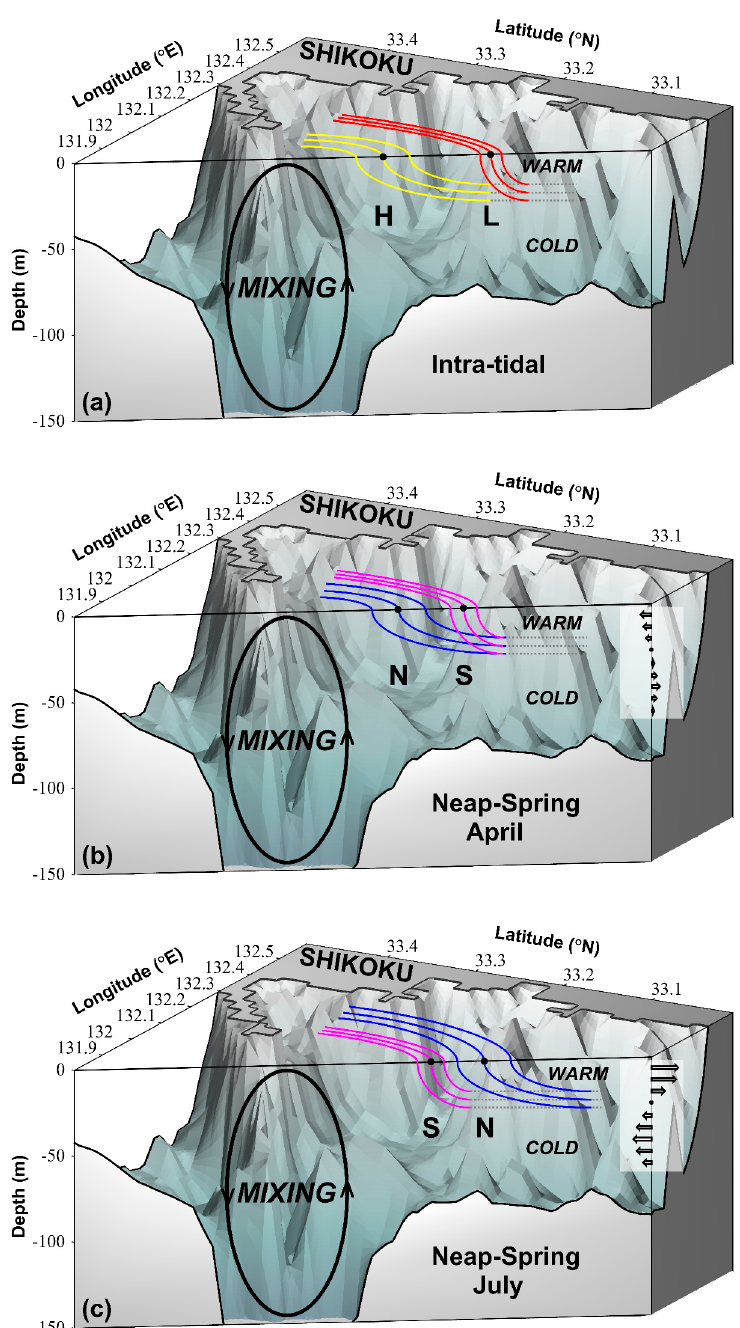
Figure 11. ( a ) Schematic of the intra-tidal variation in position and intensity of the tidal front. The yellow and red lines denote the isothermal lines for the front at the end of the flood (H) and ebb (L) current phases, which have small and large gradients, respectively. Schematics of the fortnightly variations of the front in ( b ) April and ( c ) July. Blue and pink lines indicate the isothermal lines during neap tide (N) and spring tide (S), and the horizontal arrows show the direction of the background residual currents.